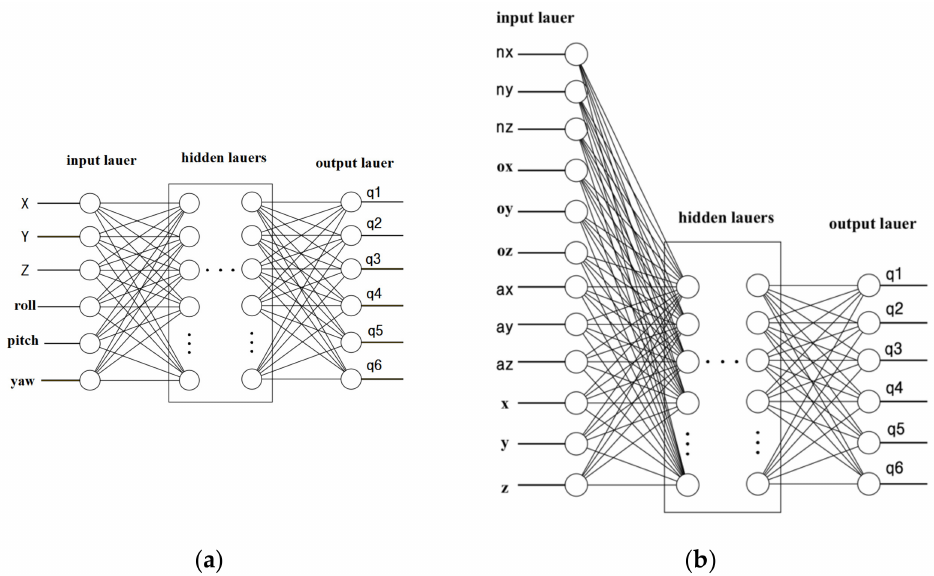
Figure 8. Neural network architecture: ( a ) RPY NN; ( b ) MATRIX